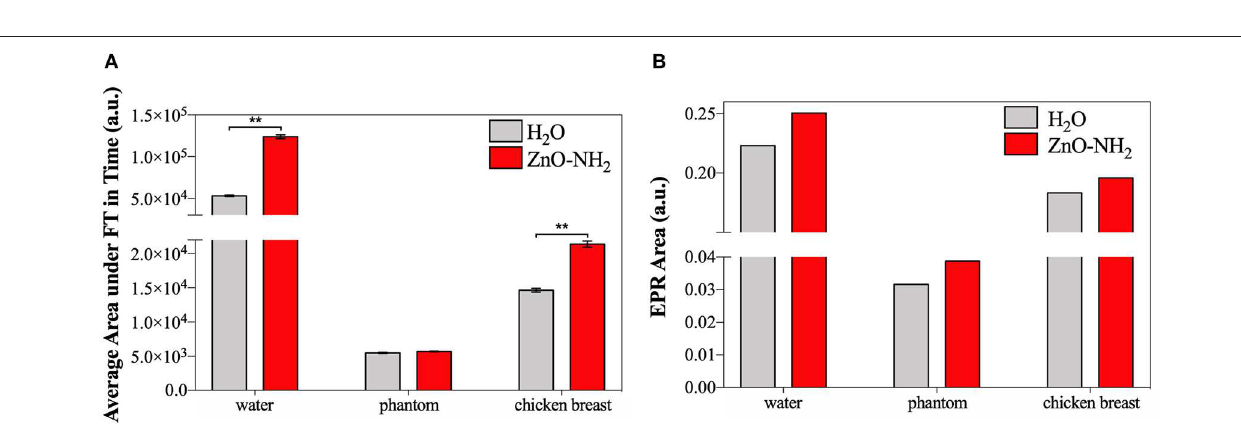
FIGURE 7 | (A) Average area under Fourier Transform, calculated with MATLAB, of signals recorded in time by cavitometer during ultrasound irradiation. One-way ANOVA was performed to determine statistical significance (* p < 0.05 and ** p < 0.001). (B) Area under the EPR spectrum curve measured with Bruker SpinFit